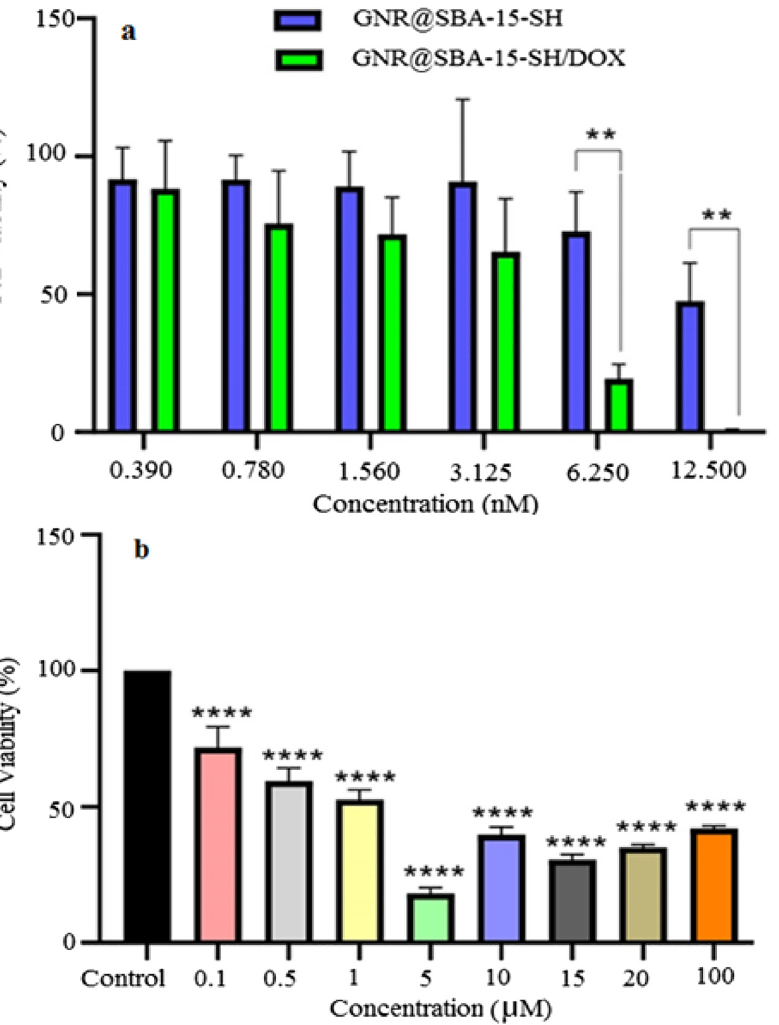
Table  : IC  of free DOX, GNRs@SBA-  -SH, and GNRs@SBA-  -SH/DOX after  h incubation in A 